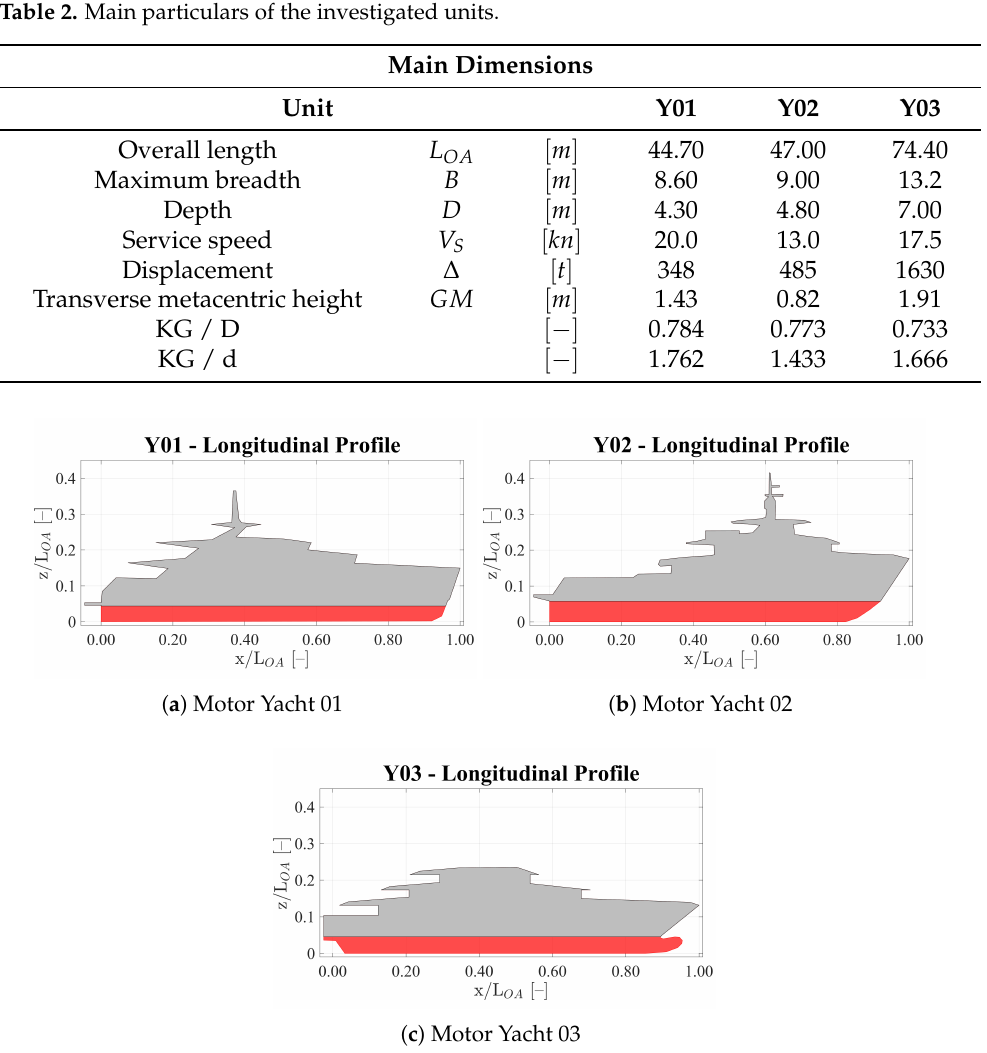
Figure 1. Graphical representation of the lateral exposed areas for the investigated